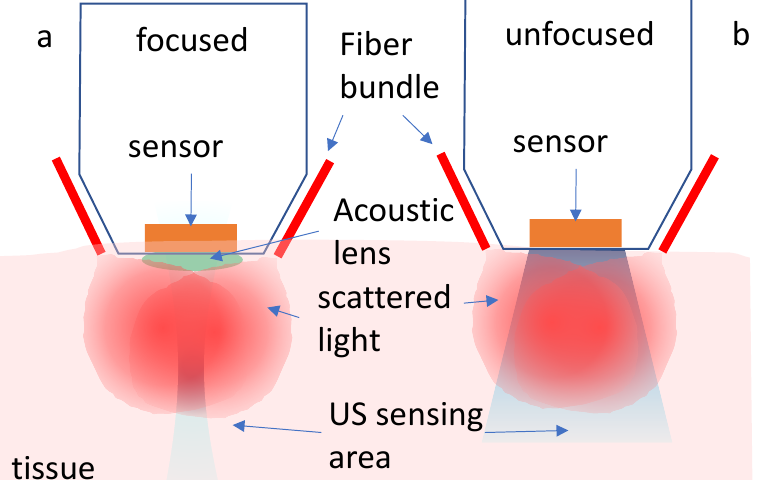
Figure 1. An illustrative comparison between ( a ) the conventional, focused probe design and ( b ) the proposed, unfocused design. The unfocused design is also sensitive to signals from superficial tissue depths but lacks elevational focusing. In both designs, dark-field illumination is provided by fiber bundles.